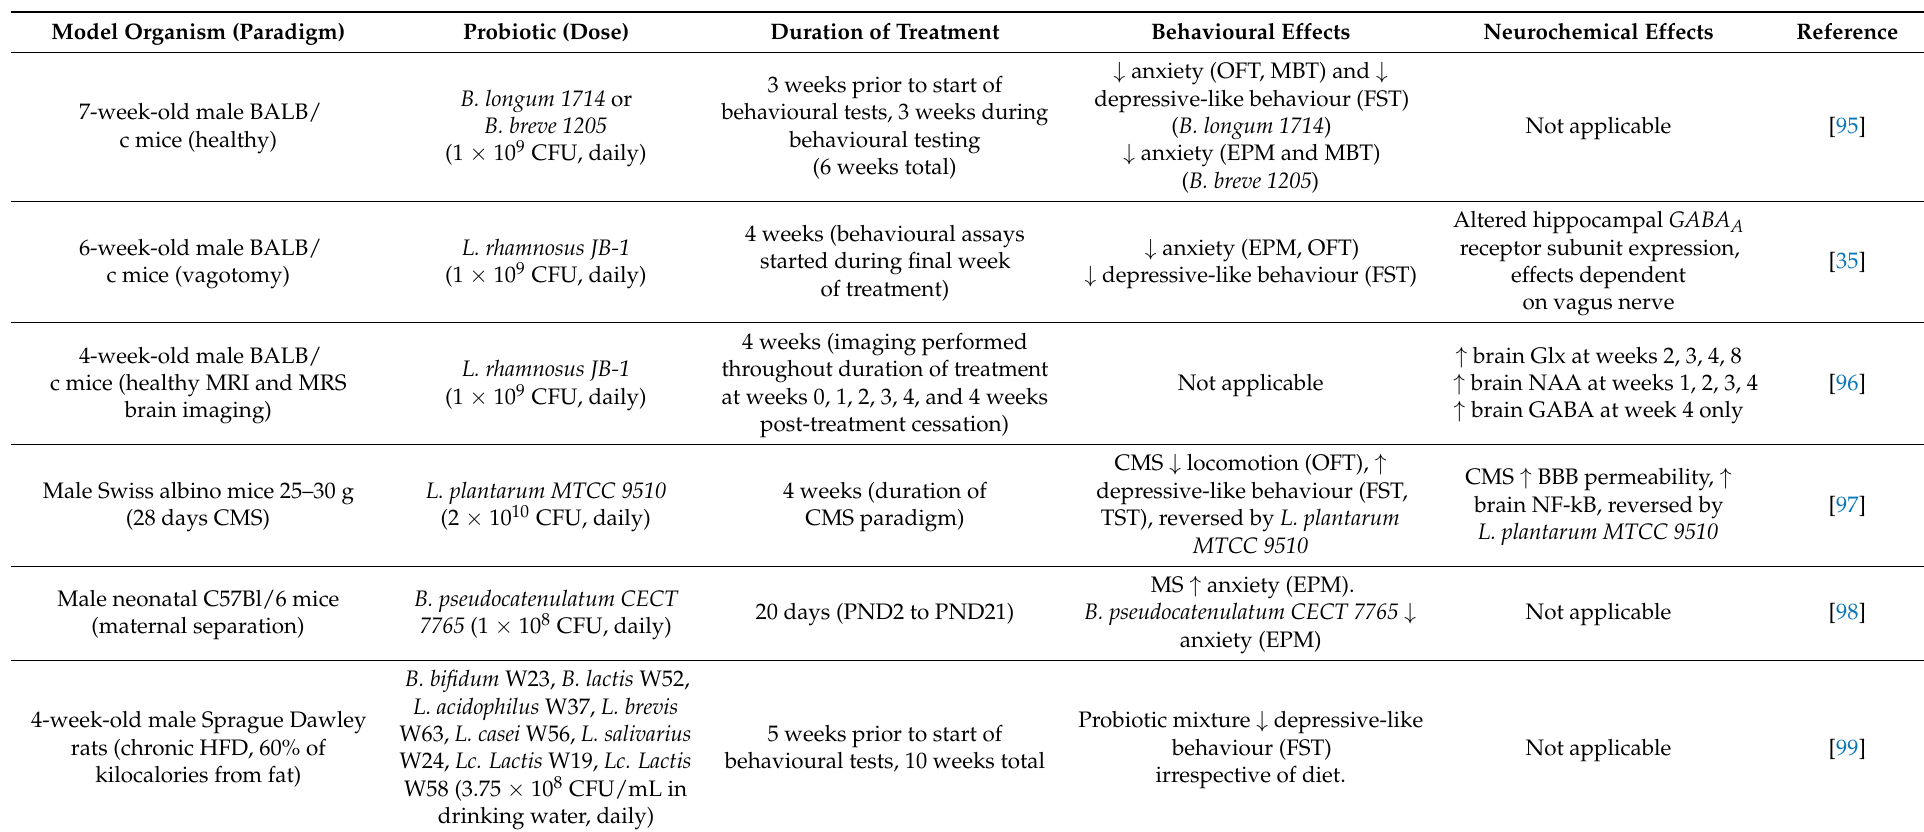
Table 1. Summary of probiotic studies in rodent models on anxiety and depressive-like behaviours and brain metabolism. ↑ increase, ↓